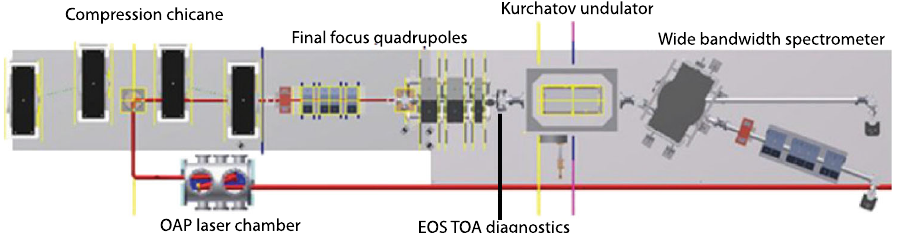
FIG. 2. Diagram of interaction region for the UCLA-LLNL IFEL experiment. The high power Ti ∶ Sa laser (in red) is focused in the OAP chamber, goes through a periscope that preserves its horizontal polarization, and is sent down the beam line using an on axis mirror located the center of the chicane compressor. The electron beam from the S-band linac approaches from the left, is compressed in the chicane, and is focused to a waist at the center of the undulator by two quadrupole triplets.